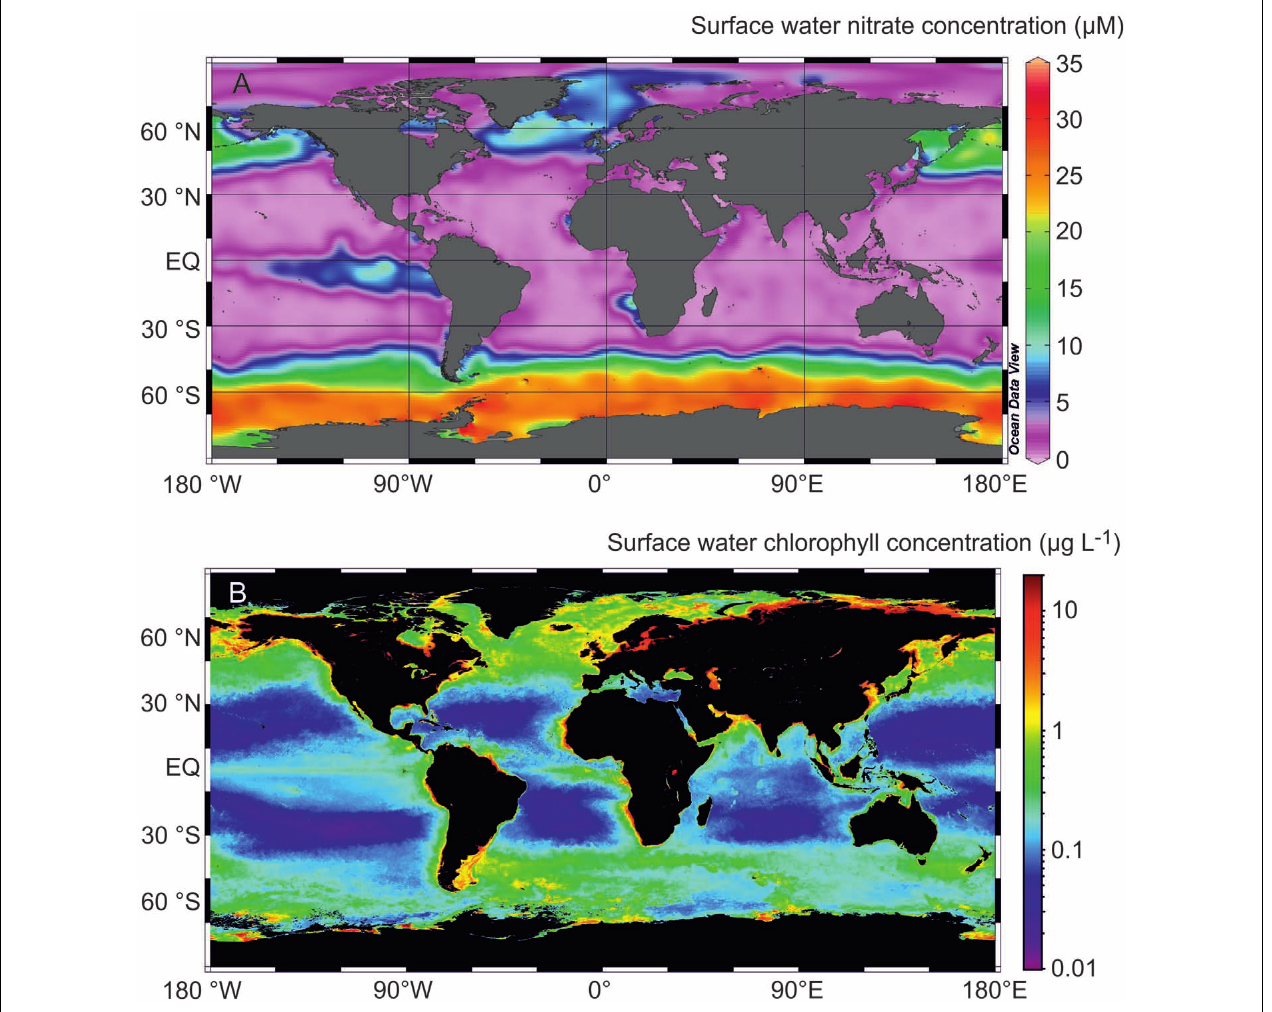
(http://www.nodc.noaa.gov/OC5/WOA09/pr_woa09.html), while the chlorophyll a distribution represents the 2009 Aqua MODIS chlorophyll composite